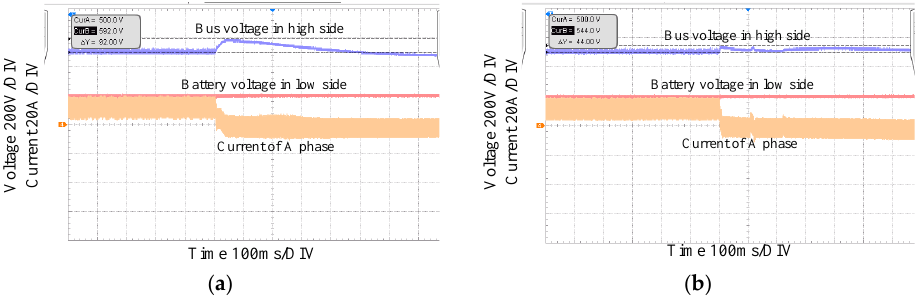
Figure 12. Bus voltage and A-phase current waveform when 11 kW loads are cut off: ( a ) the bus voltage and A-phase current waveform with the improved feed-forward control; and ( b ) the DC bus voltage and A-phase current waveform without the feed-forward control.